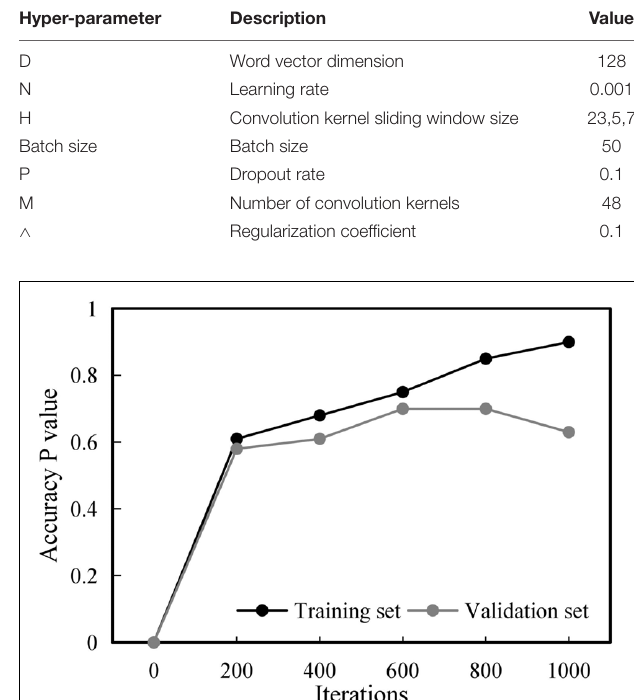
TABLE 2 | Model hyper-parameter setting.